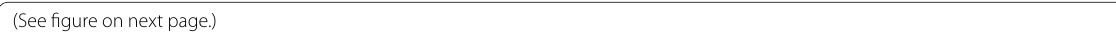
cross section; II, lumber obtained near the pith (sometimes including pith on the surface area of the lumber); III, lumber obtained from outer part of the logs (without pith). Values in parentheses followed by correlation coefficients are p -values obtained by a test of no correlation